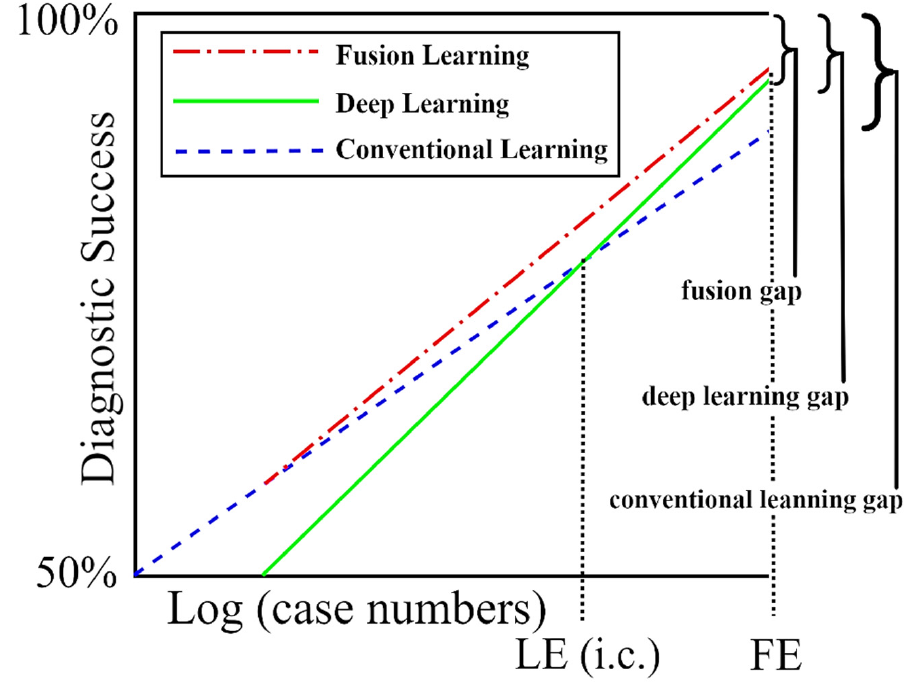
Figure 6. The success of deep learning (DL) with and without domain knowledge (conventional learning). As the number of training cases increases, DL becomes more accurate than conventional learning with LE (Learning Equilibrium) training cases, and finally becomes as accurate as fusion learning with FE (fusion equilibrium) training cases. At some future number of training cases, we reach a point where the deep learning gap equals the fusion gap. From [49], with permission.